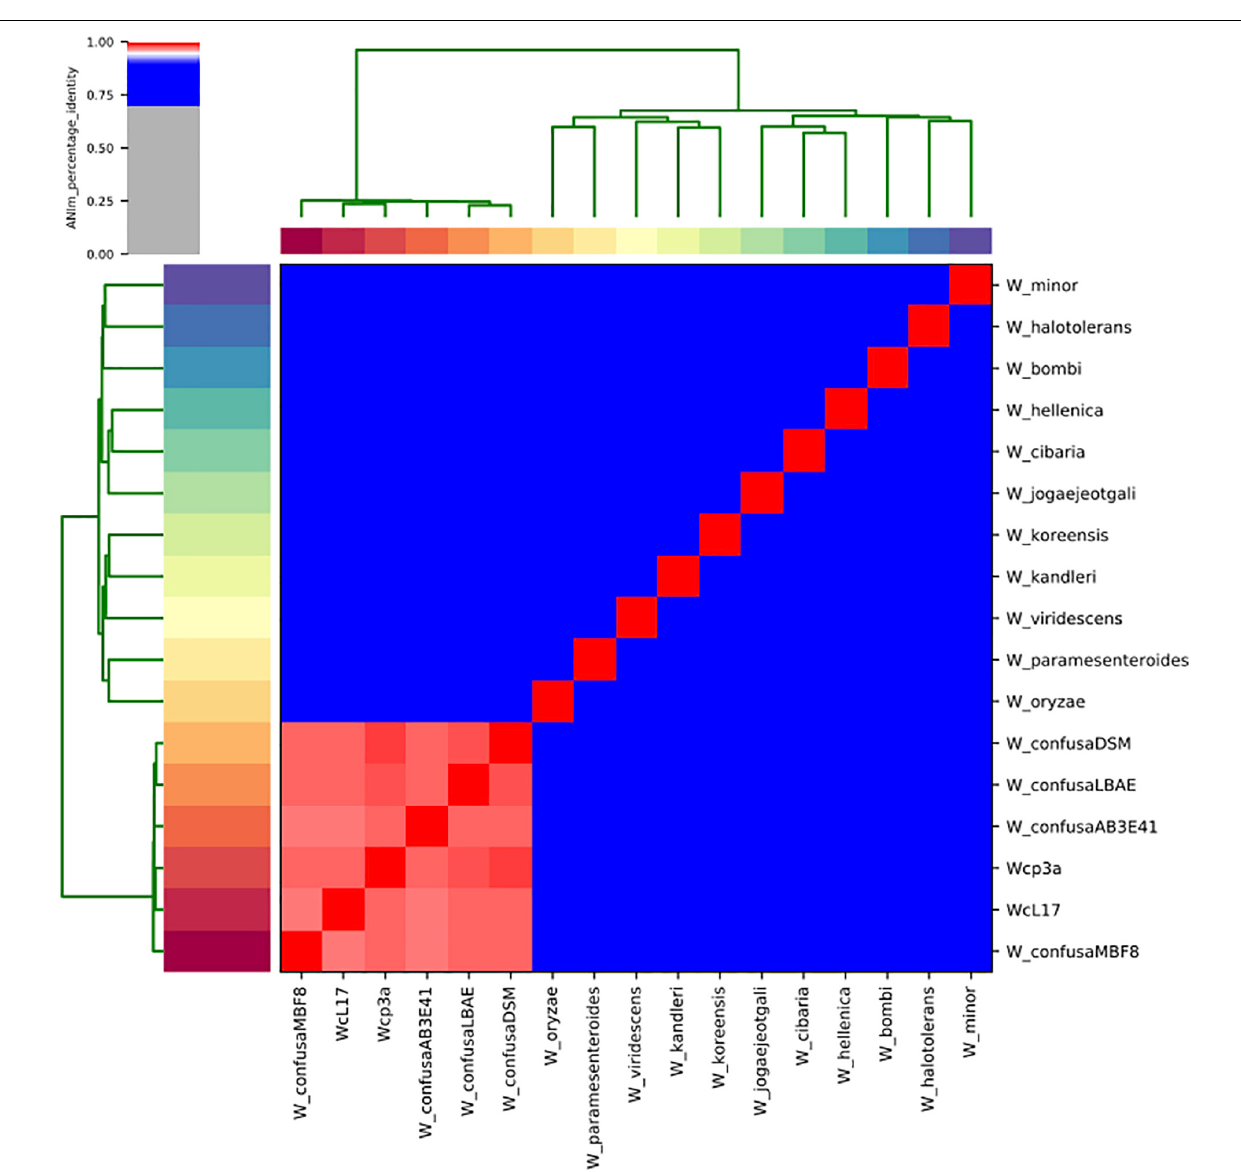
FIGURE 4 | Heatmap of Average Nucleotide Identity (ANI) values of representative Weissella genera reported in the literature ( Table 1 ), including genomes for strains WcL17 and WCP3a. Strains with ANI values > 90% are shown within red